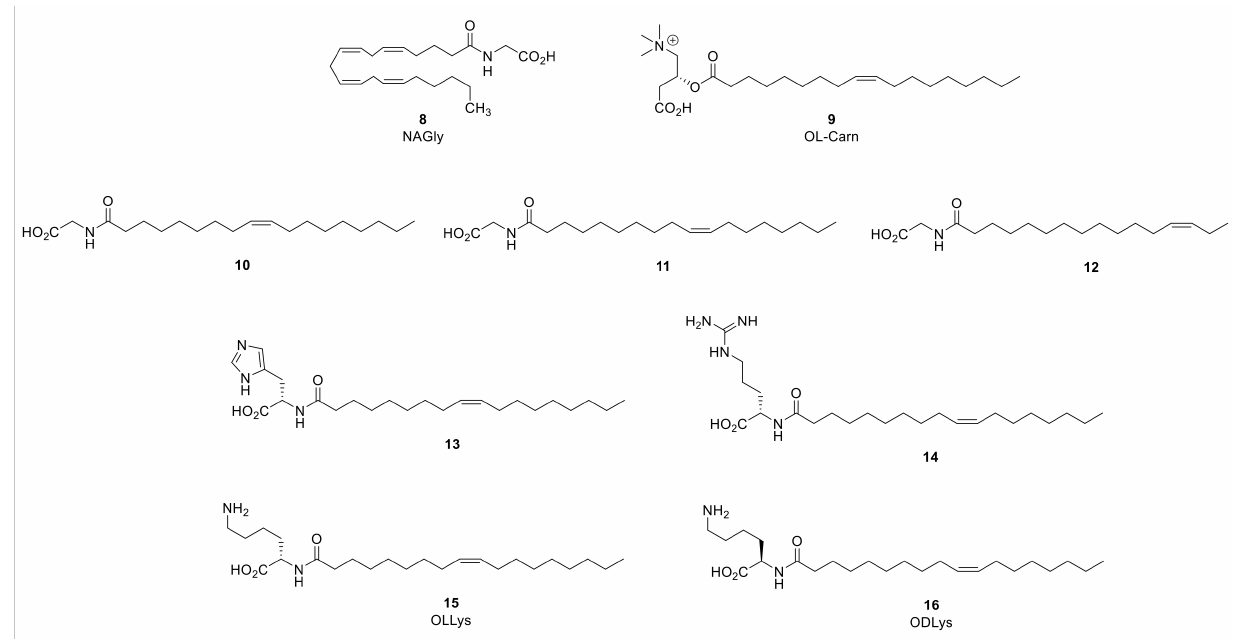
Figure 5. Bioactive lipid GlyT2